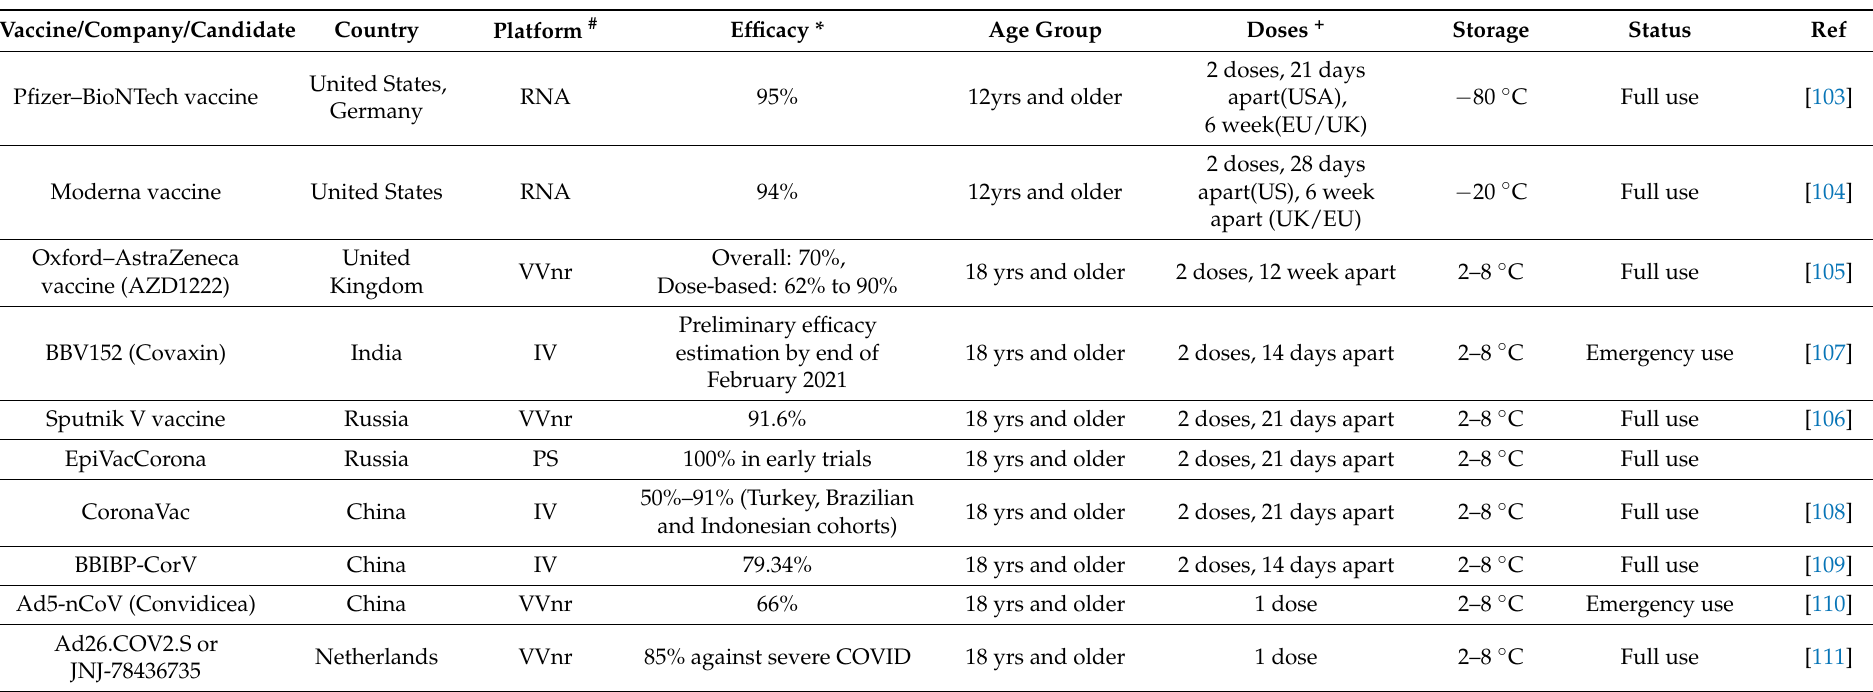
# Refer Table 1, * Symptomatic infection and severe disease, + Intramuscular